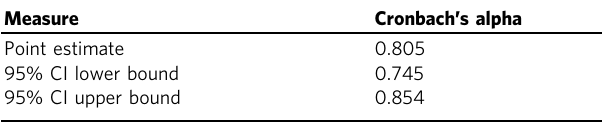
Table 2 Reliability statistics for frequentist